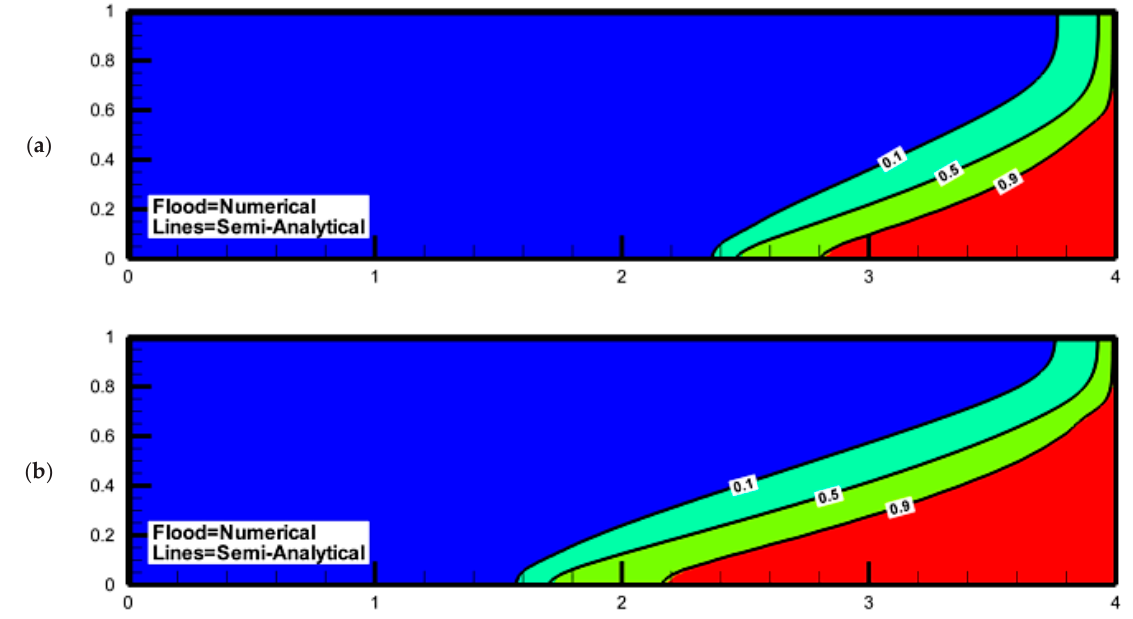
Figure 5. Semi-analytical and numerical isochlors (10%, 50%, 90%) for the dispersive cases: ( a ) homogenous and ( b ) heterogonous aquifer.